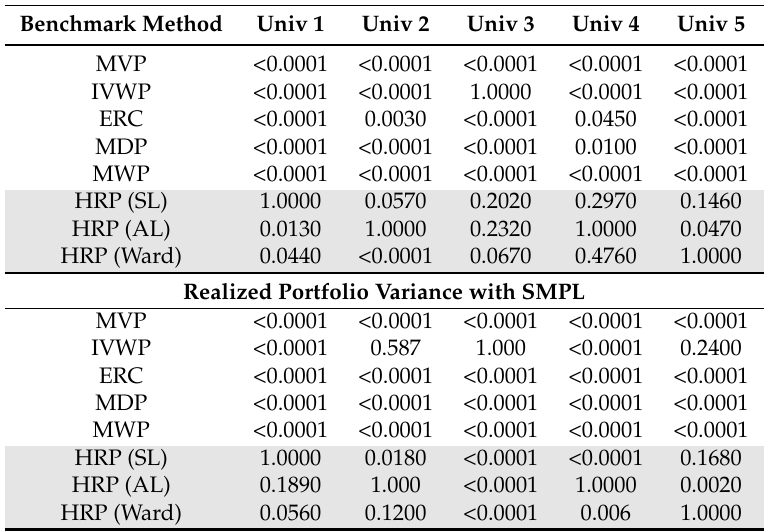
Table 4. p c -values for different portfolio allocation benchmark models considered when DCC-GARCH is used for estimating the covariance matrix and the portfolio is rebalanced daily. The highlighted cells are outcomes for variants of